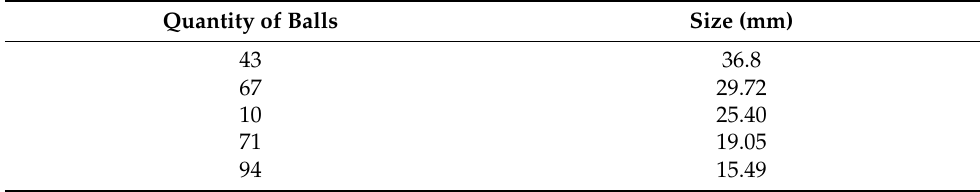
Table 1. Distribution of steel balls for the Bond test